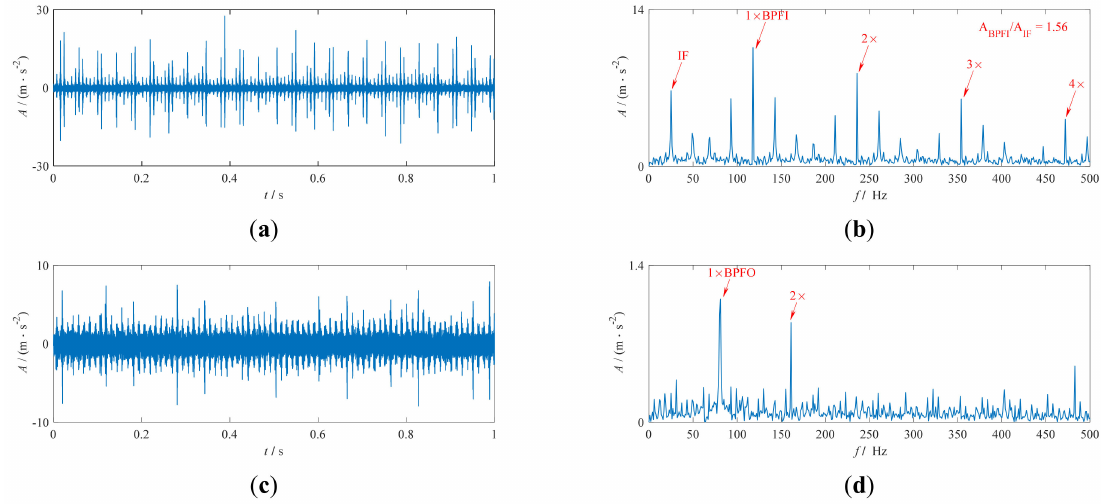
Figure 7. Signals from MFPT: ( a , b ) correspond to the TDW and SES of the inner race fault bearing; ( c , d ) correspond to the TDW and SES of the outer race fault